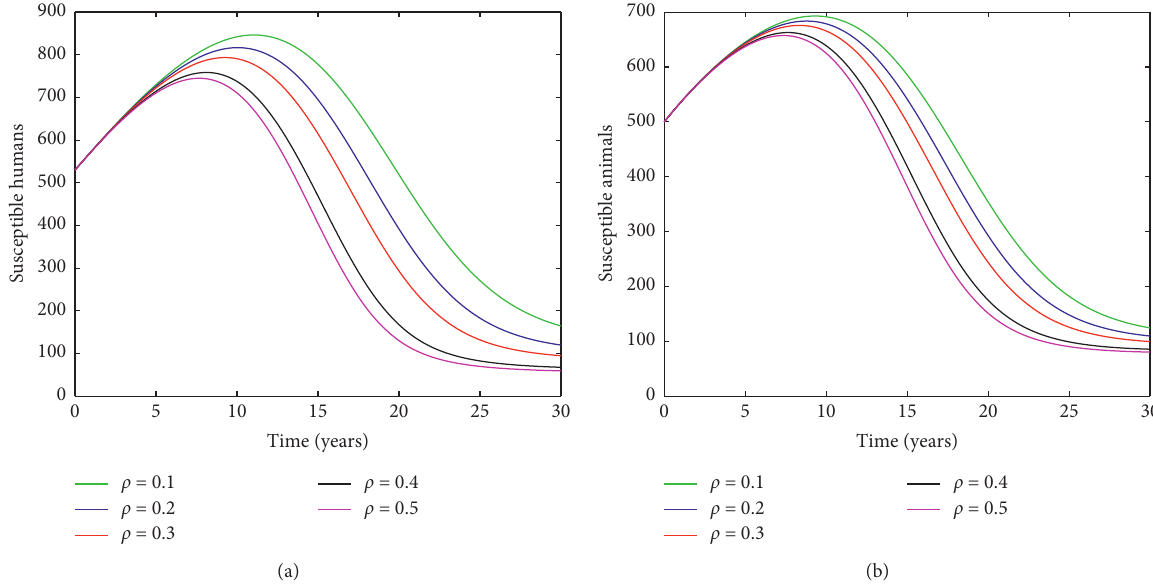
Figure 3: Variation of the dairy production rate into susceptible (a) humans and (b) animals with change in time.